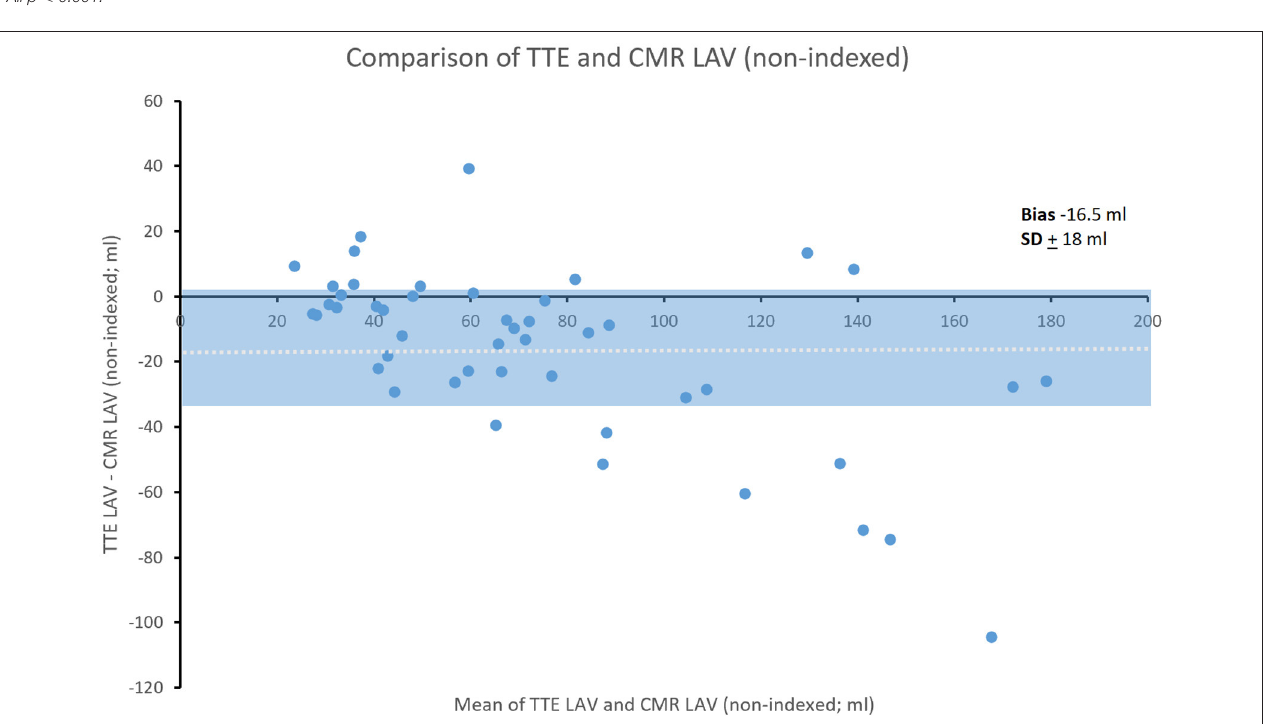
FIGURE 3 | Bland-Altman comparison of TTE and CMR non-indexed LAV. Shading represents ± SD. Dotted line indicates mean bias. Both groups had similarly preserved LVEF but reduced